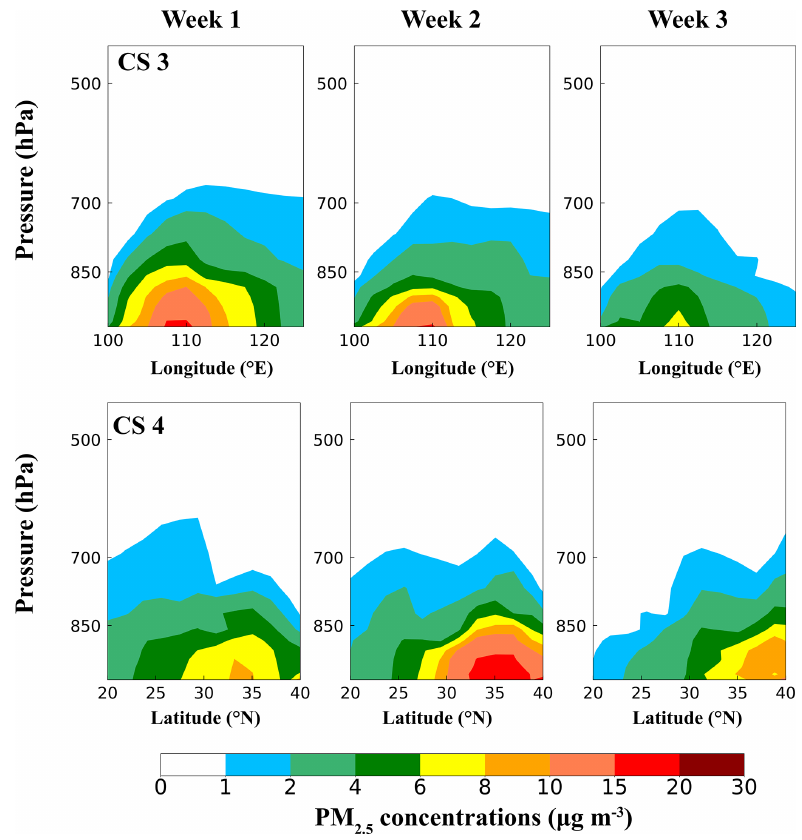
Figure 5. Vertical distributions of PM 2 . 5 concentrations (µgm − 3 ) originating from domestic emissions in China across the latitudinal and/or longitudinal extents marked in Fig. 1, respectively, during the three time periods. The values along CS 1 and CS 2 are negligibly